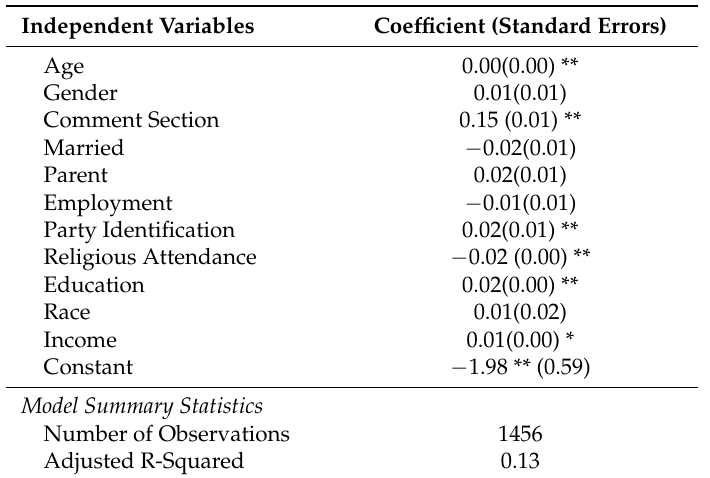
Table 4. Ordinary Least Squares (OLS) regression analyzing the connection between posting to online comment sections and engaging in political activity